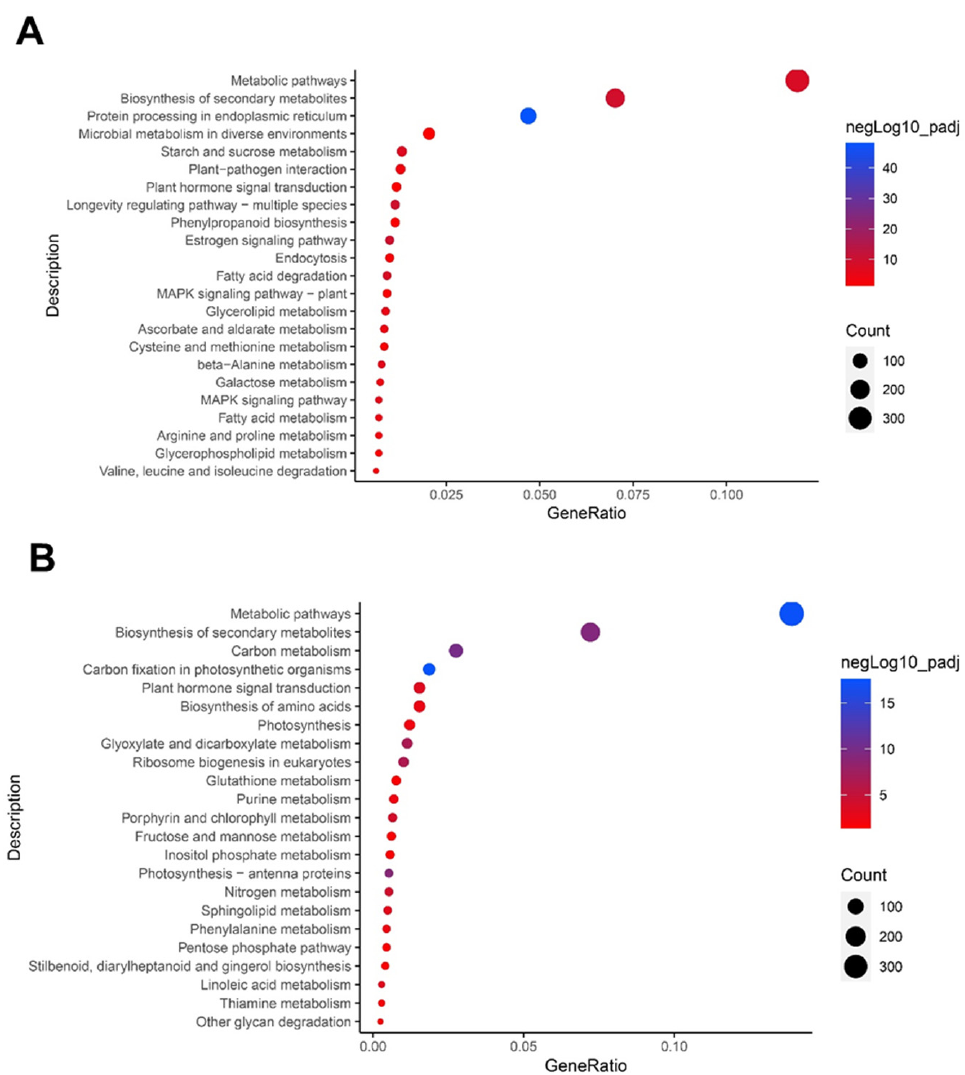
Figure 5. Upregulated ( A ) and downregulated Kyoto Encyclopedia of Genes and Genomes (KEGG) pathways ( B ) in drought-treated garlic leaves. Top 23 KEGG enriched pathways from upregulated differentially expressed genes (DEGs) and 23 from downregulated DEGs were selected. ABA is derived from carotenoids, which are a group of C40 natural pigments [2]. In the carotenoid and ABA biosynthesis pathway, beta-carotene hydroxylase (BCH) is responsible for the hydroxylation of beta-carotene [27], ABA deficient 4 (ABA4) catalyzes the isomerization of neoxanthin and violaxanthin [28,29], and 9- cis -epoxycarotenoid dioxy- genase (NCED) acts as the key rate-limiting enzyme by cleaving 9- cis -violaxanthin and 9 (cid:48) - cis -neoxanthin [30]. ABA 8 (cid:48) -hydrolase catalyzes the first step in ABA degradation